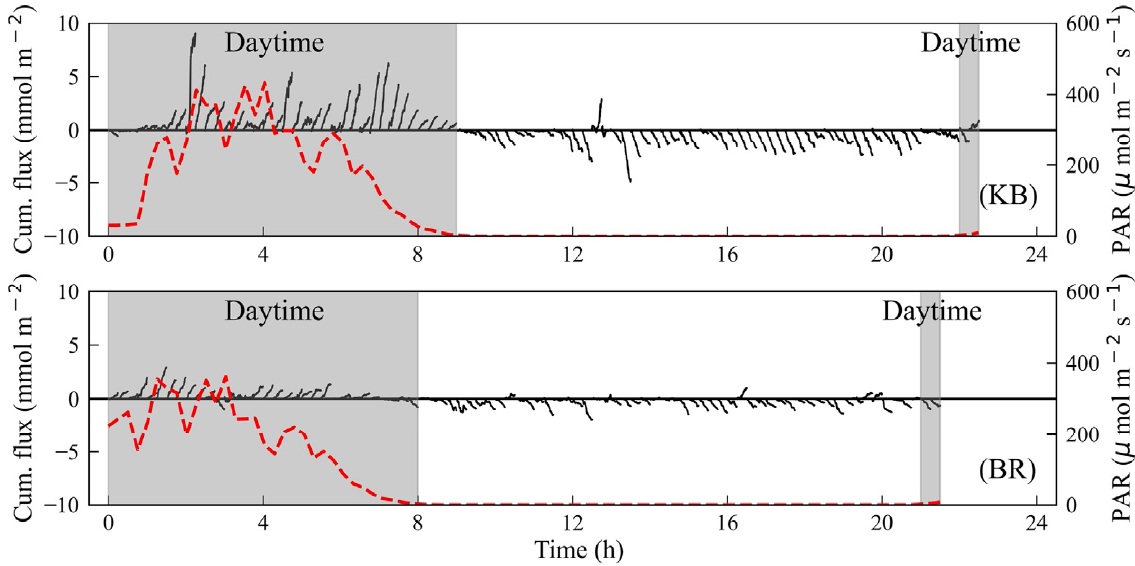
Figure 5. Time series (15 min burst) of cumulative O 2 flux (black solid line) and PAR (red dashed line) in KB and BR. The cumulative flux shows a clear diurnal pattern with PAR.